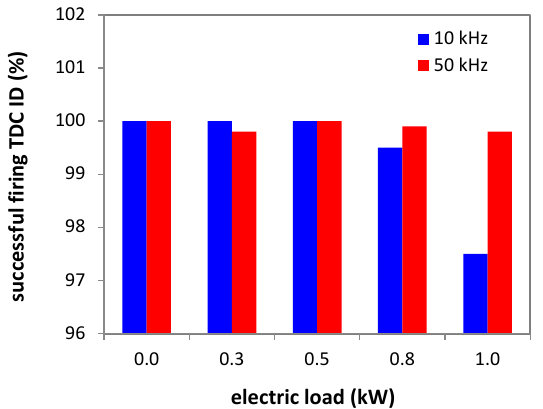
Figure 12. Success rate of firing TDC identification for the spark duration method in odd/even mode